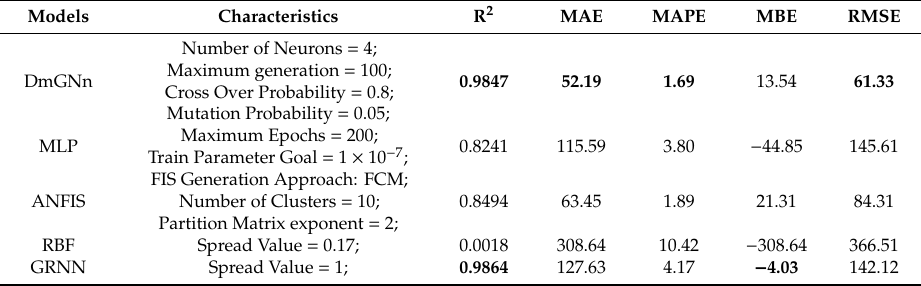
Table 5. Statistical errors for each prediction